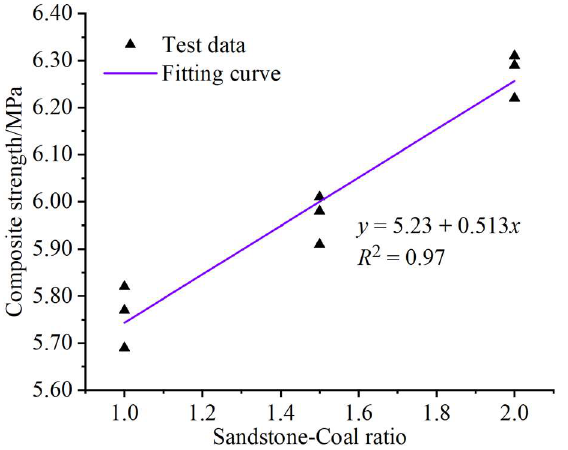
Figure 4. Effect of coal–rock thickness ratio on the strength of the coal–rock